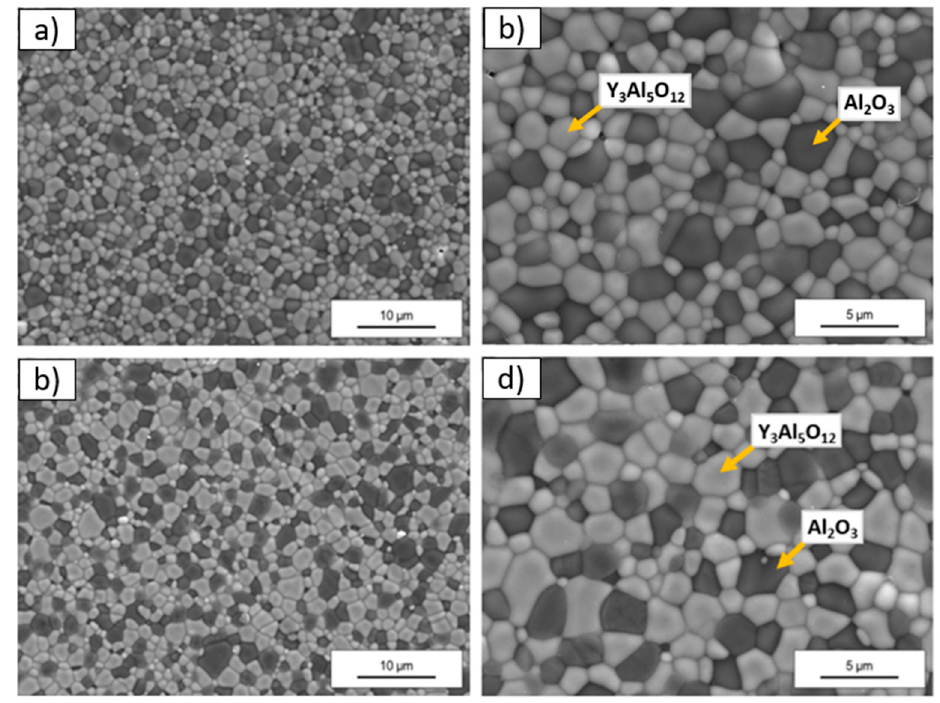
Figure 7. SEM micrographs of Al 2 O 3 –YAG composites sintered at: ( a ) and ( b ) 1600 °C for 2 h; ( c ) and ( d ) 1650 °C for 2 h.